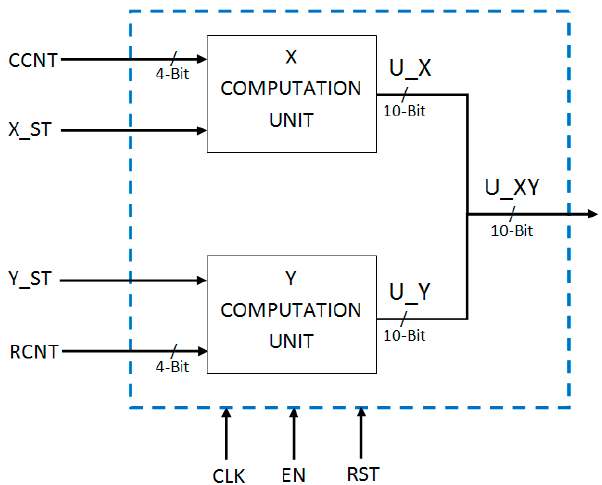
Figure 12. Block diagram of new location computation unit. CCNT → Column Counter; RCNT